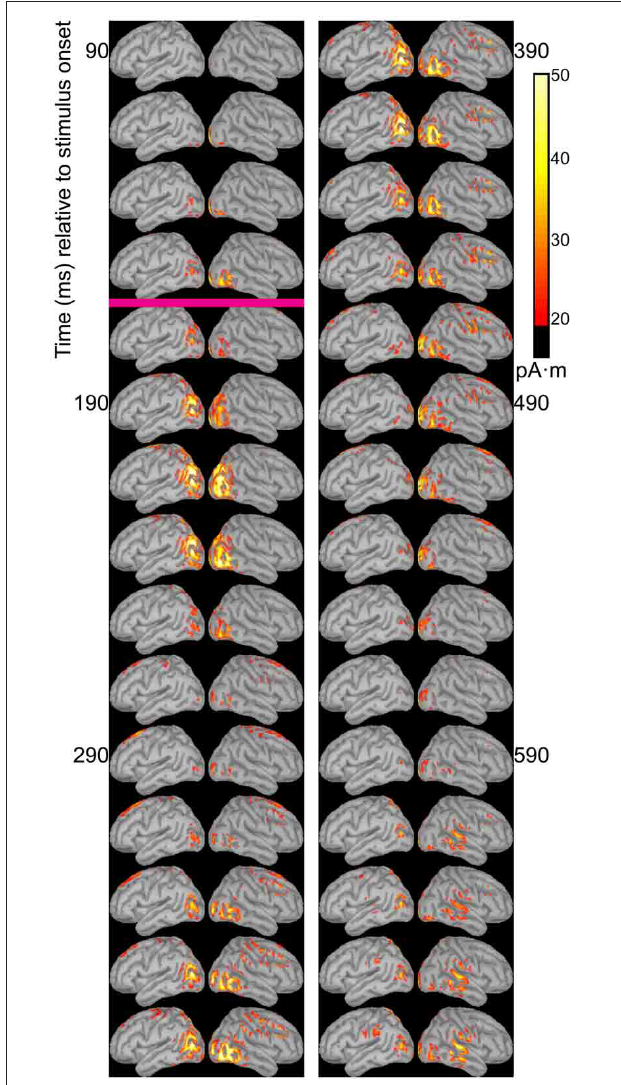
FIGURE 6 | Source images for “ta” standard. Images show the depth-weighted minimum norm estimate of dipole source strength constrained to the surface of the cortex using a boundary element forward model and a generic anatomical model at 20-ms intervals starting from 90ms after the onset of visible motion for the group mean ERPs for syllable “ta” as standard . The magenta bar indicates the time at which “ta” visibly differs from “zha.” Images are thresholded at 20 pA · m. Initial activity is in occipital cortex. At 130ms after syllable onset, bilateral posterior temporal activity begins that fades by 250ms post-stimulus onset, but then recurs from 330 to 590ms on the right and from 330 to 470ms on the left. Fronto-central activity is visible from 270 to 470ms post-stimulus